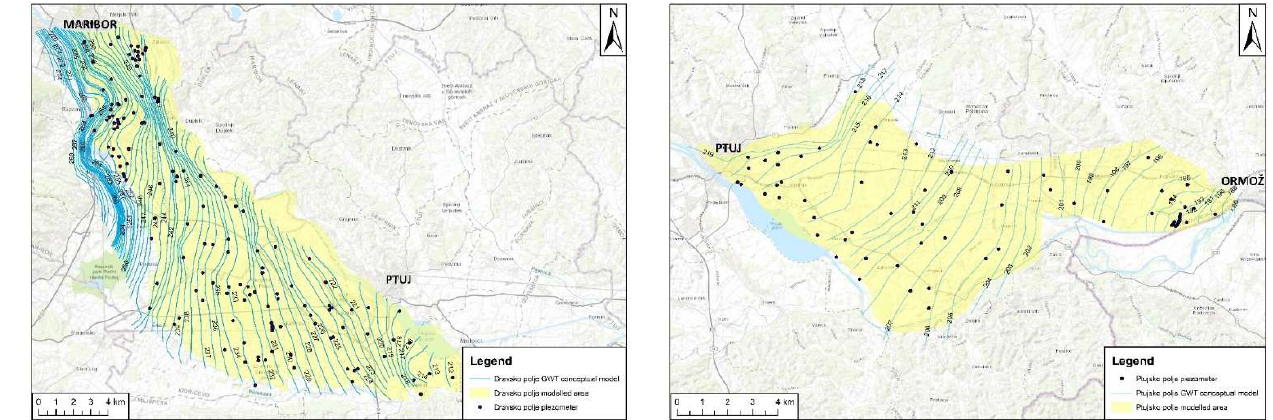
Figure 4. Groundwater level map of the Dravsko polje aquifer ( left ) and groundwater level map of the Ptujsko polje aquifer ( right ).